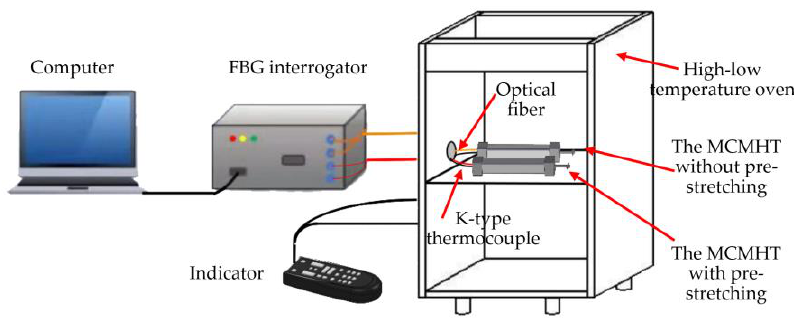
Figure 3. Co-cure experimental setup for the MCMHT with the axial preload tool. Table 2. The detailed experimental conditions.